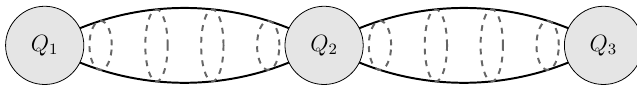
Figure 12: A sample charged black hole microstate. This one has three centers, each with an associated charge, as well as topological bubbles stretched between each adjacent